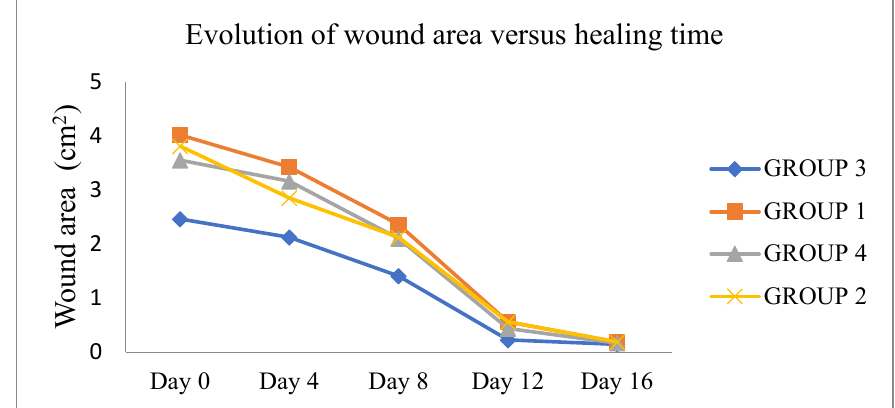
Figure 3 . Regression curve of the wounded area on the days of measurement for each treatment. G1—MEBO containing 0.25% of β-sitosterol; G2—negative control; G3—white petrolatum (vehicle); and G4— E. spinosissimus methanolic extract ointment (MEO).